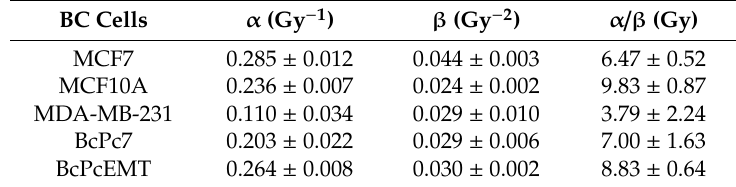
Table 1. The α , β , and α / β values calculated by the linear quadratic (LQ) model application. Table 1. The α, β, and α/β values calculated by the linear quadratic (LQ) model application. BC